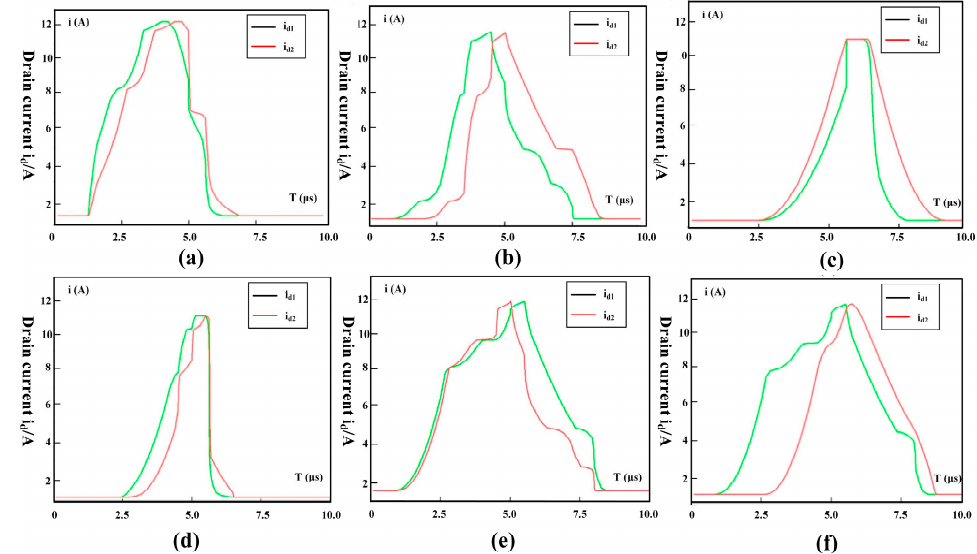
Figure 16. Parallel current equalization with multiple parasitic parameters based on the combination of a magnetic ferrite inductor and a gate drive circuit: ( a ) gate parasitic inductance, L g ; ( b ) drain